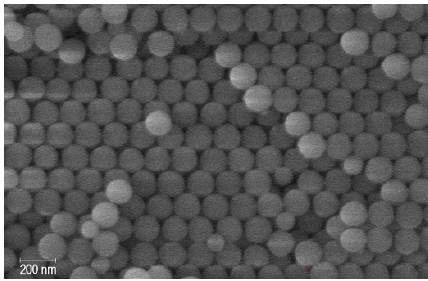
Figure 1. SEM image of the opal matrix.